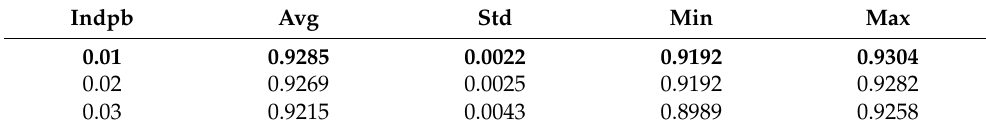
Table 5. Results after varying the value of each gene to be changed